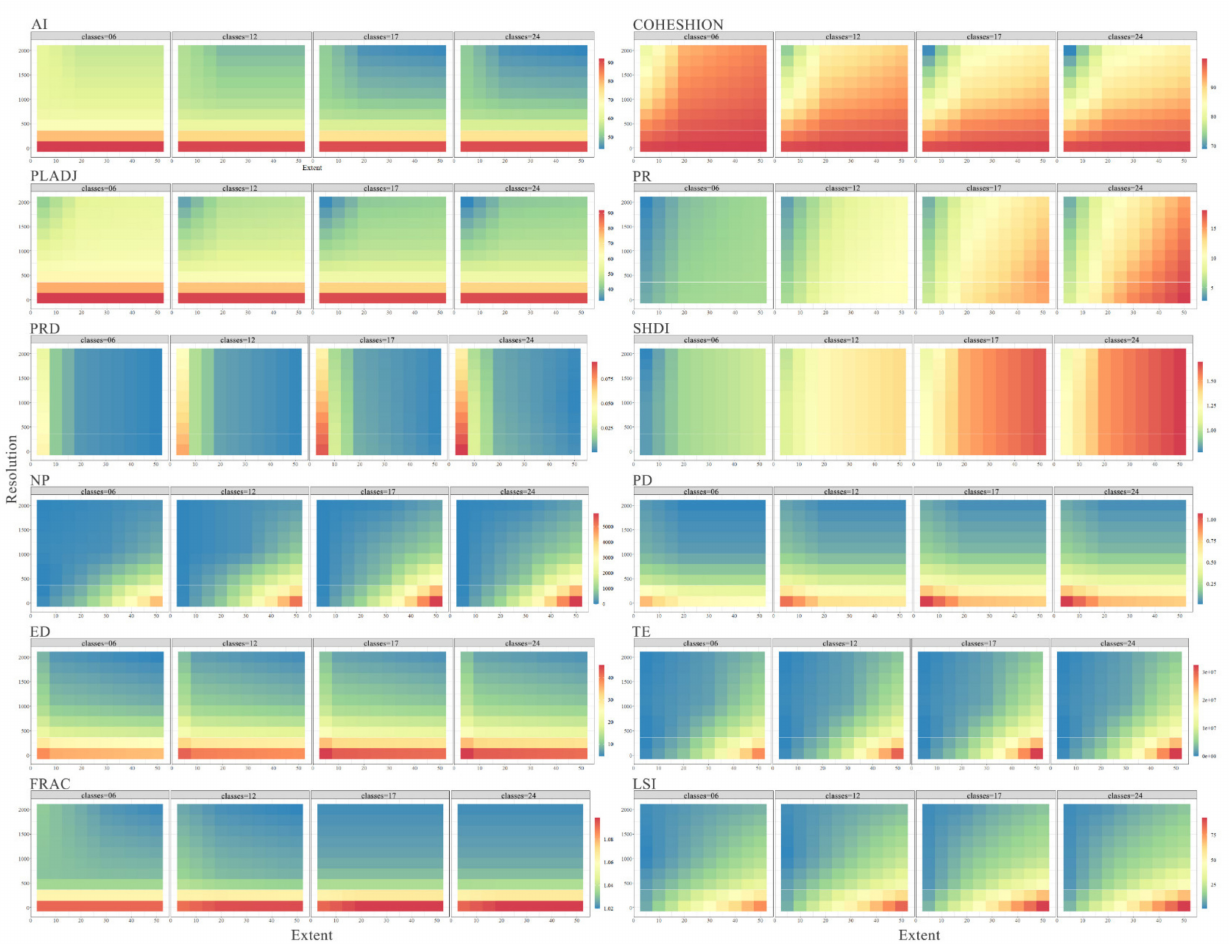
Figure 6. The scaling response heat maps of 12 landscape metrics to three-scale